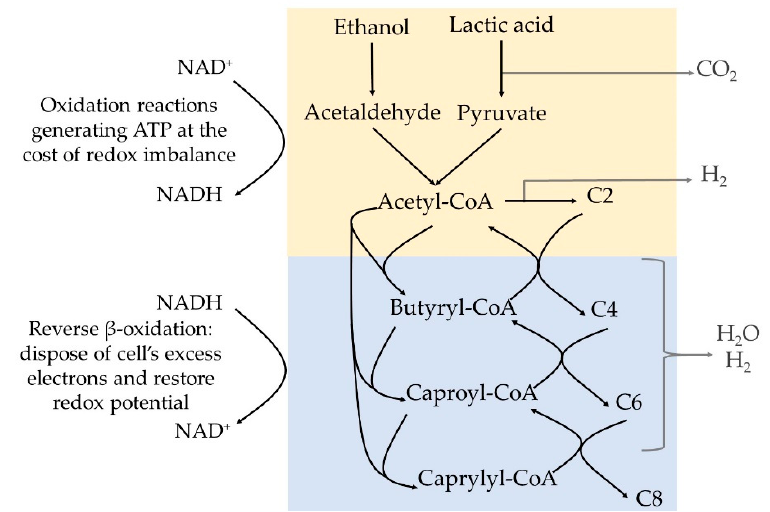
Figure 1. Simplified chain elongation pathways using ethanol or lactic acid as electron donors based on the metabolic pathways described in [29] .